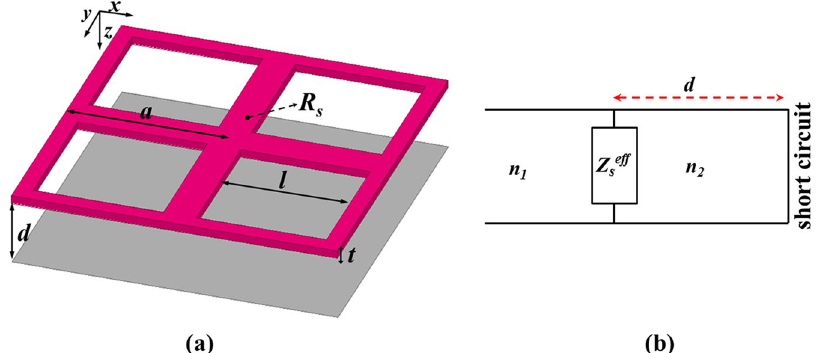
Figure 1. ( a ) Schematic of a metasurface absorber layer. ( b ) Equivalent transmission